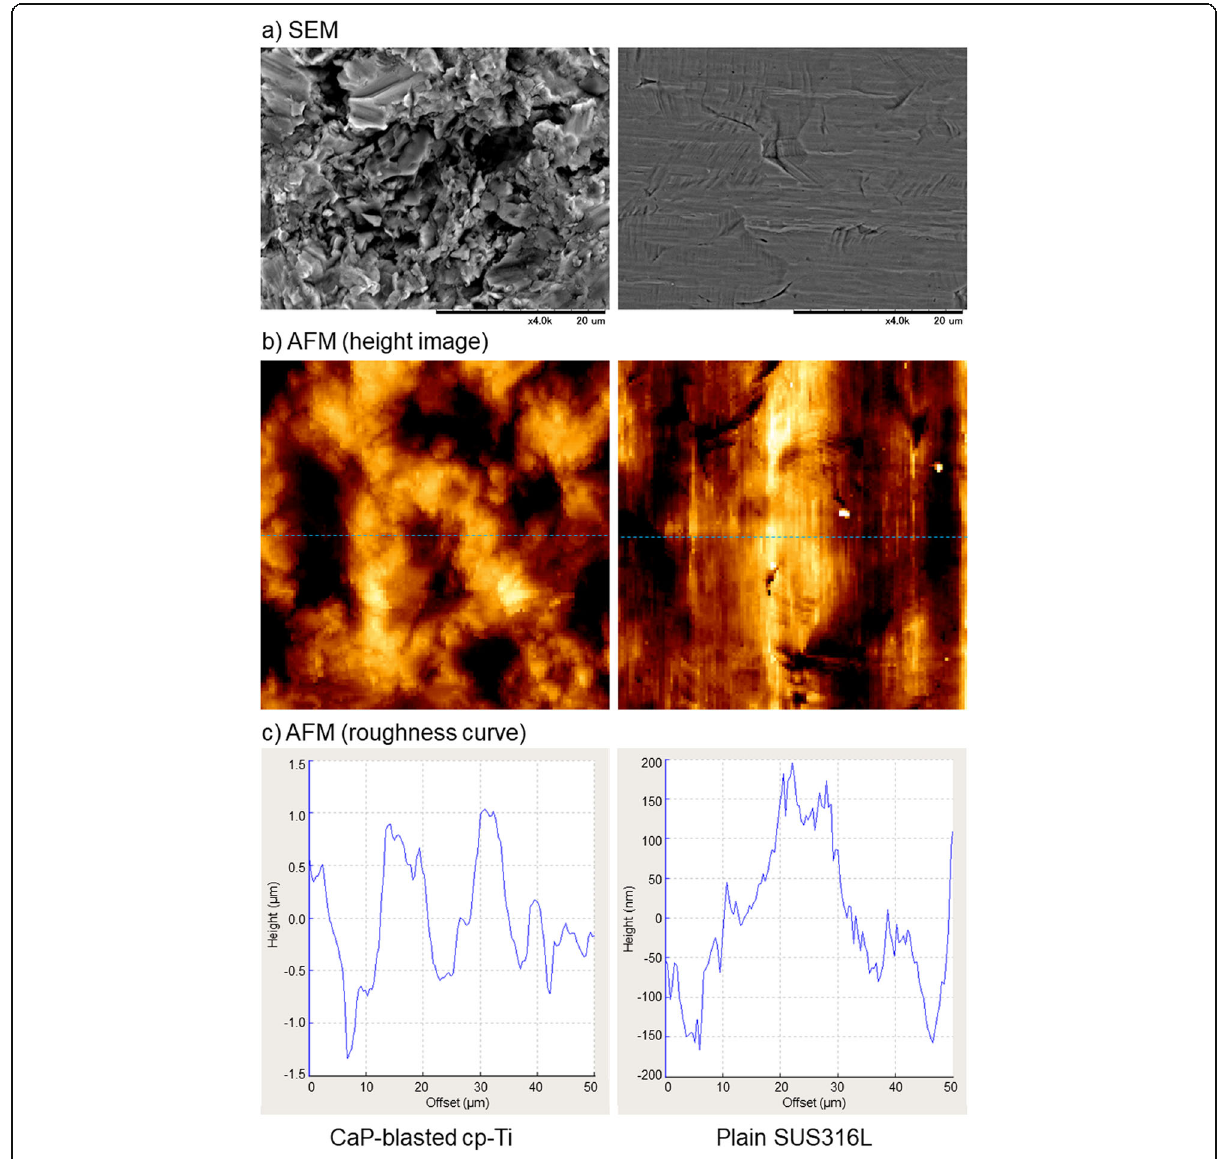
Fig. 1 Surface microstructure of CaP-blasted cp-Ti and plain SUS316L plates. a The plates were directly sputtered without fixation or dehydration process and subjected to SEM examination. b The plates were directly subjected to AFM examination. Size of the height images is 50 × 50 μ m. c Roughness profiles were drawn from the height images (blue dashed